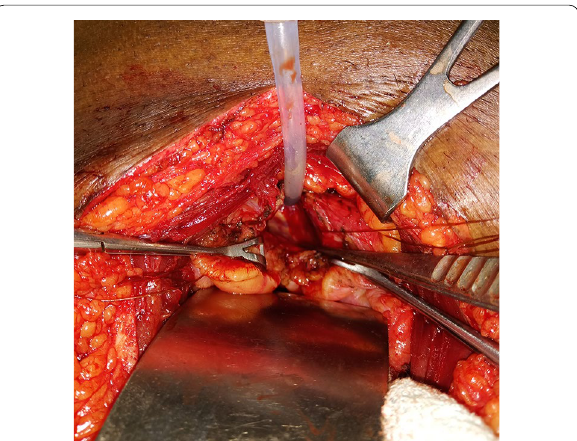
Fig. 6 Intraoperative picture showing thimble opened